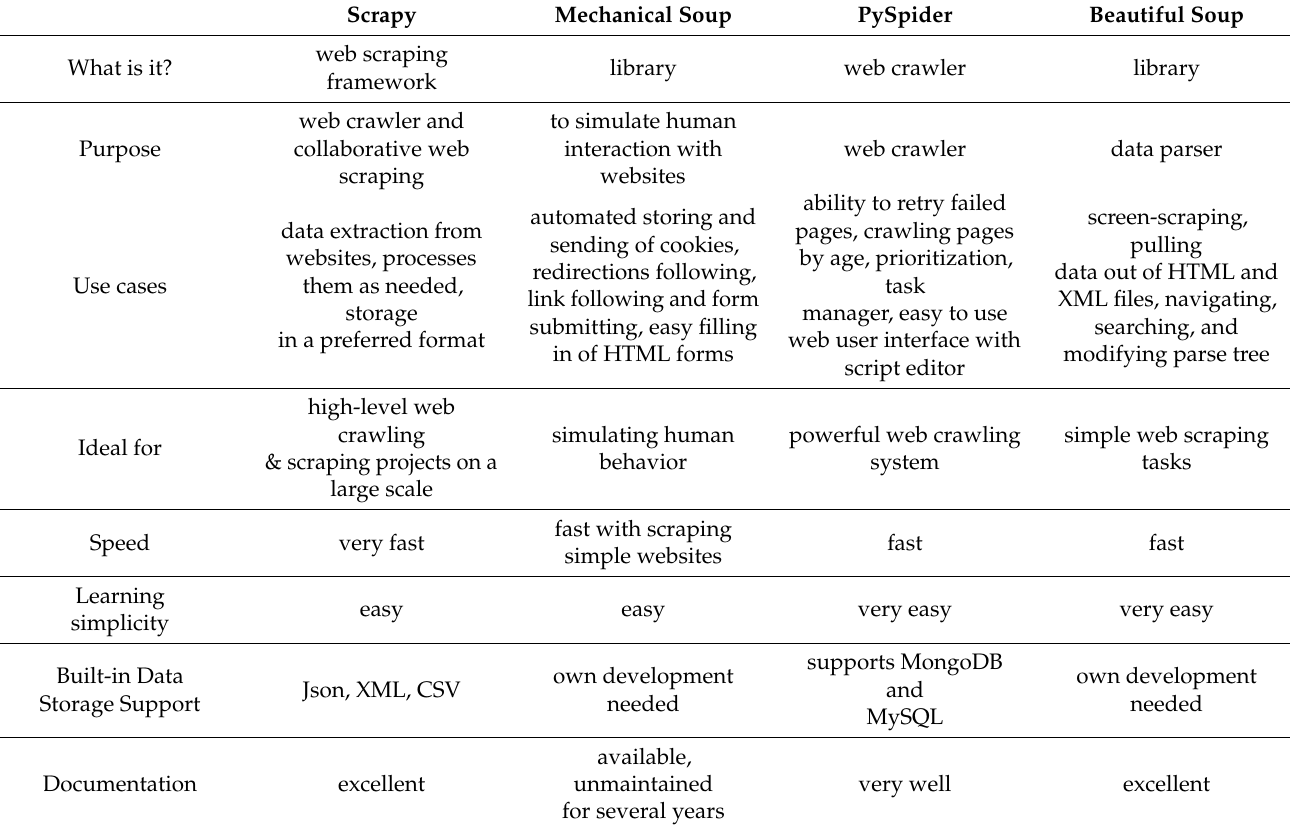
Table 1. Decision table—overview of web scraping and web crawling